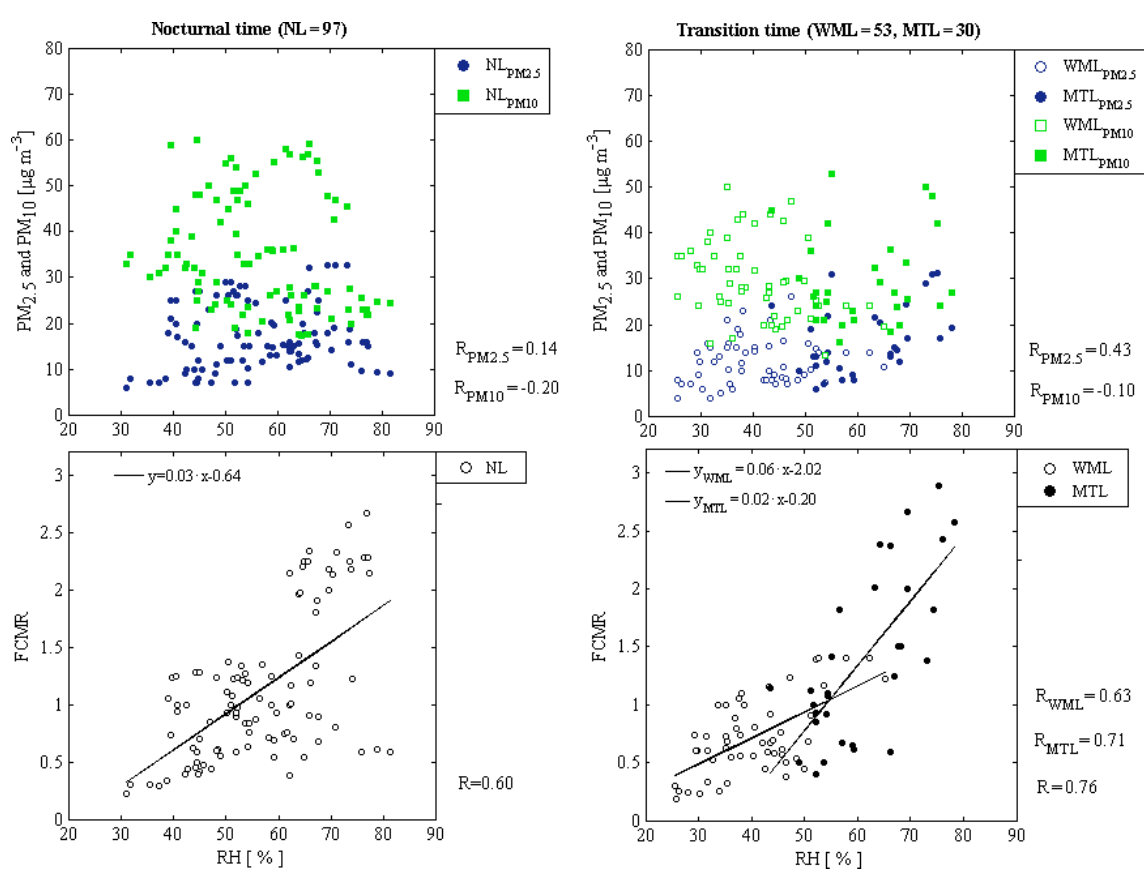
Figure 9. Hourly averaged near-surface relative humidity (RH) measured by the WXT510 (Vaisala) weather transmitter at the RS-Lab in Warsaw for the July–September period of 2013, 2015, and 2016 vs. surface particulate matter (PM 2 . 5 and PM 10 ) measured at the WIOS site in Ursynow, Warsaw. The linear fit to data points is shown for correlation coefficients ( R ) greater than